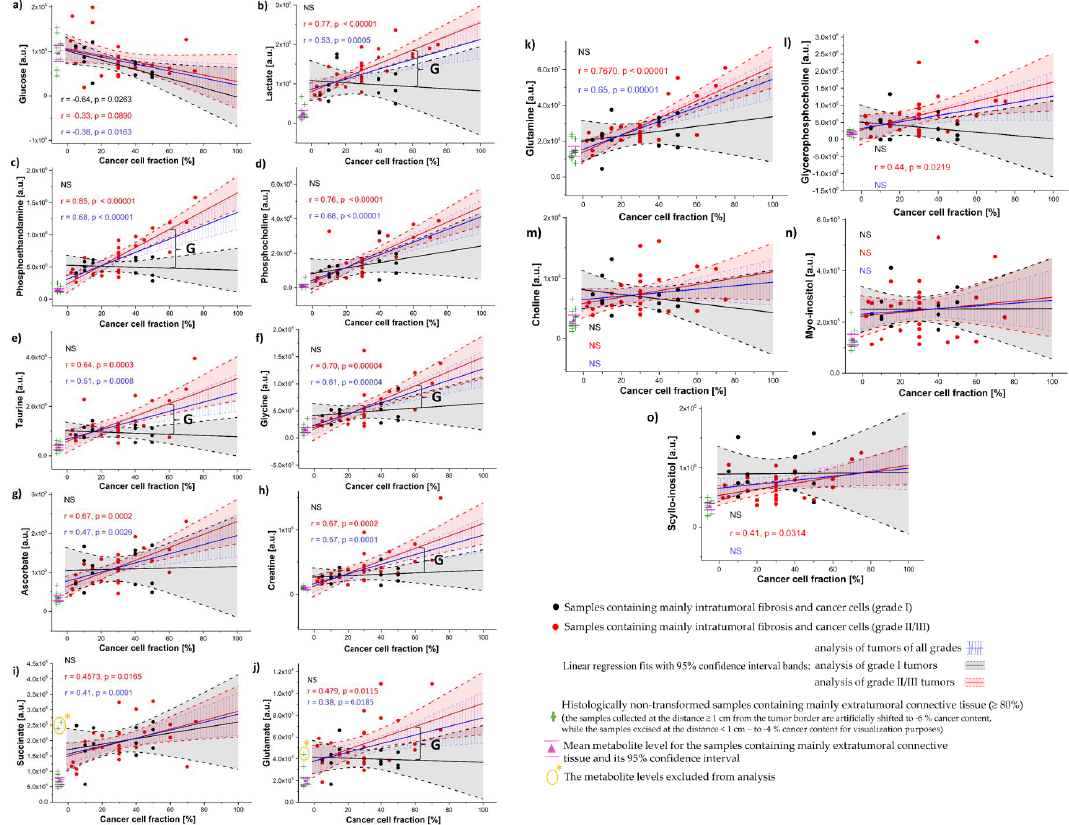
Figure 9. The relationships between glucose ( a ), lactate ( b ), phosphoethanolamine ( c ), phosphocholine ( d ), taurine ( e ), glycine ( f ), ascorbate ( g ), creatine ( h ), succinate ( i ), glutamate ( j ), glutamine ( k ), glycerophosphocholine ( l ), choline ( m ), myo-inositol ( n ), scyllo-inositol ( o ) and a cancer cell fraction. The linear fits (blue solid lines—the analysis of the tumors of all grades, black solid lines— the analysis of the grade I tumors, red solid lines—the analysis of the grade II/III tumors) with 95% confidence bands (blue dashed lines—the analysis of the tumors of all grades, black dashed lines—the analysis of the grade I tumors, red dashed lines—the analysis of the grade II/III tumors) were calculated for the samples containing mainly intratumoral fibrosis and cancer cells. Pearson correlation coefficients (r) between metabolite levels and cancer cell fraction are highlighted in blue (for tumors of all grades), black (for grade I tumors) and red (for grade II/III tumors). The levels of the metabolites corresponding to pure intratumoral fibrosis and pure cancer are determined from the extrapolation of the regression lines to 0% and 100% cancer content. Additionally, the metabolite lev- els measured in the samples representative of extratumoral fibrous connective tissue (green crosses) are presented. The pink triangle and pink lines indicate the mean metabolite levels obtained for these samples and their 95% confidence intervals. The significant differences between the grade I tumors and the grade II/III tumors are marked with a curly bracket (and a G letter) at a cancer cell fraction of 60%. Two outlying integral intensities in the spectral region corresponding to succinate (marked with a yellow asterisk) were not included in the calculation of the mean level of this metabolite in the fibrous connective tissue beyond tumor. A prominent singlet at 3.70 ppm assigned to polyethylene glycol (a component of optimal cutting temperature (OCT) fixative) was detected in 1 H HR-MAS NMR spectra acquired from the samples exhibiting the extraordinarily high succinate signals. An outlying signal intensity in the spectral region corresponding to glutamate was also present in one of these samples and was excluded from the analysis. NS—not